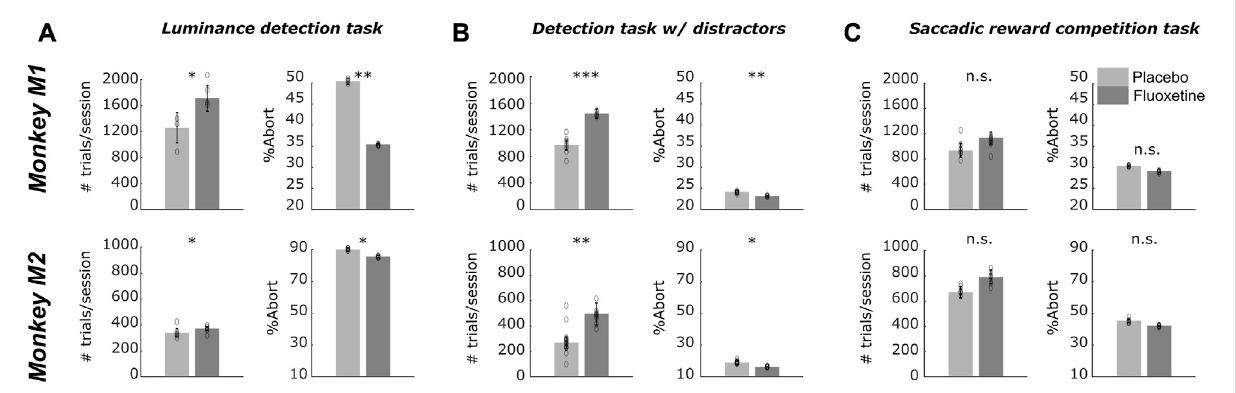
FIGURE 6 Effect of fl uoxetine on on-task motivation (# of trials) and on-task compliance (% aborts), on the Luminance detection task (A) , the detection task with distractors (B) and the saccadic reward competition task (C) . For all plots, median+/-median absolute error. of the median are represented. Placebo data are represented in light gray and fl uoxetine data are represented in dark gray. Statistical signi fi cance is represented as follows: ***, p < 0.001; **, p < 0.01; *, p < 0.05; n. s., p > 0.05. See also companion Supplementary Table S1 for detailed